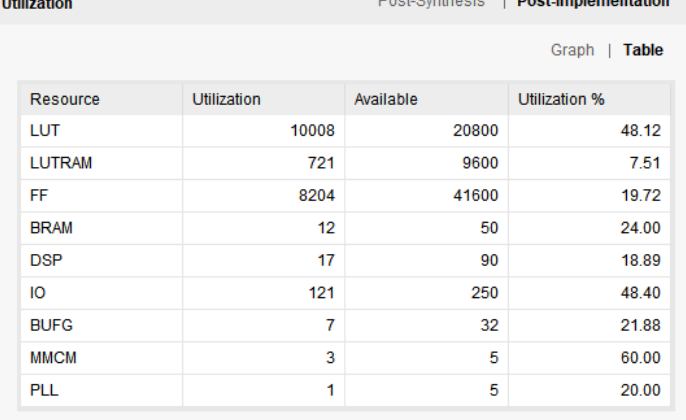
Figure 19. FPGA resource utilization.